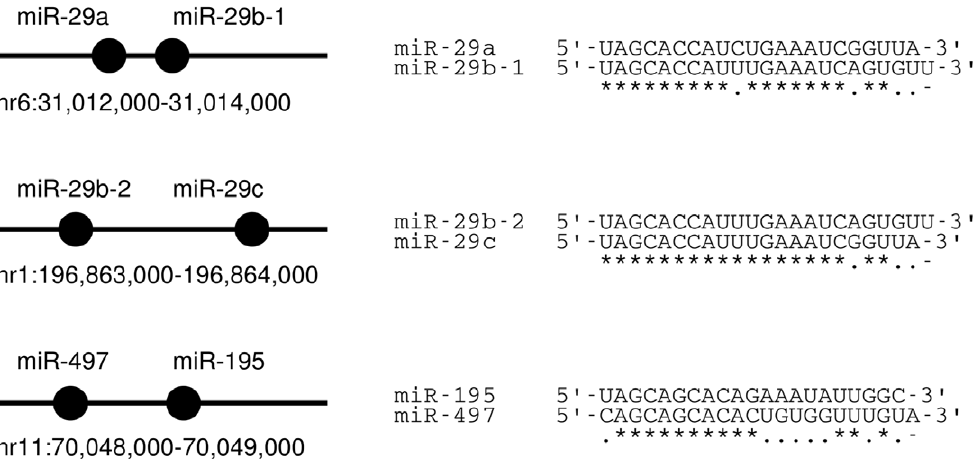
Figure 3. miR-29 and the miR-15 family members miR-195/miR-497 form three intergenic clusters in mouse chromosomes 1, 6, and 11. All three isoforms of miR-29 share the same seed sequence at nucleotides 1–8, corresponding to a sequence of UGGUGCUA in target mRNAs. miR-195 and miR-497 share the same seed sequence at nucleotides 2–8 but differ in position one.